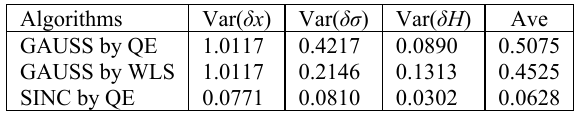
Table 2. Fluctuation analysis of three algorithms in SAR image